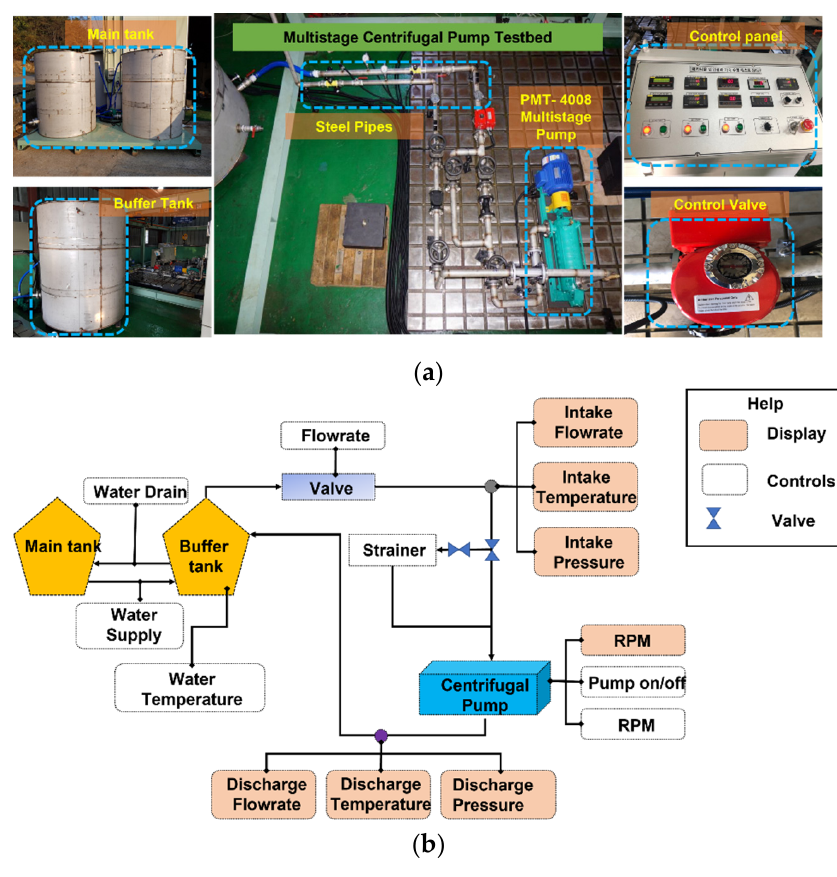
Figure 2. Pump test rig: ( a ) photograph and ( b ) schematics.